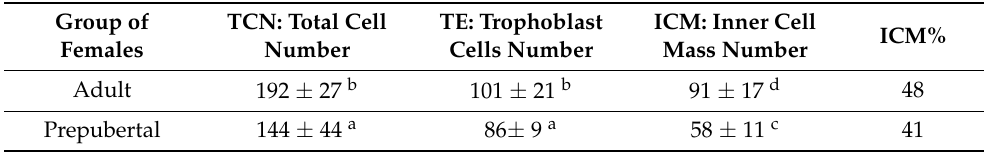
Table 4. Number of blastomeres (mean, SD) in blastocyst from adult and prepubertal domestic cats and its allocation to trophoblast and inner cell